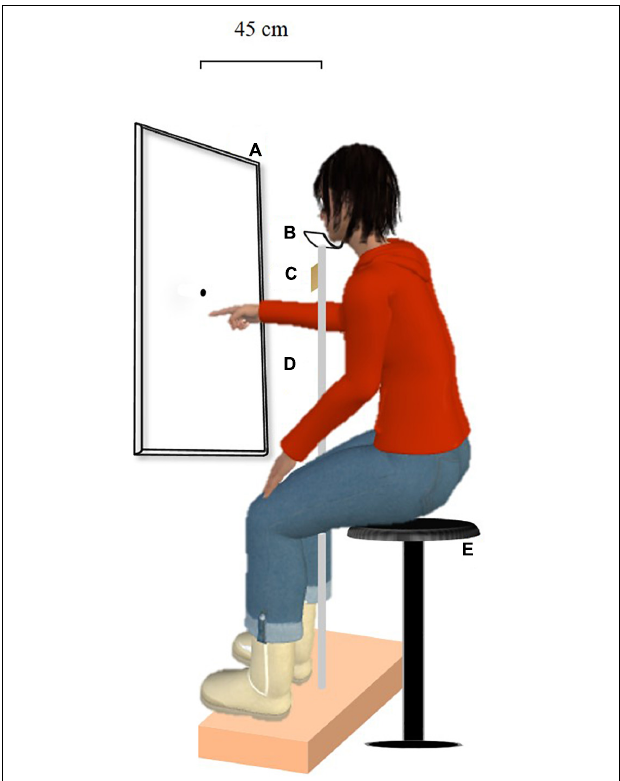
FIGURE 1 | Experimental setup. The participants were seated on a stool adjustable in height facing a touchscreen whose center was aligned with their gaze throughout all test phases. The square bracket depicts the touchscreen-gaze distance of 45 cm. (A) Touchscreen, (B) chinrest, (C) wavy surface, (D) chin rest stem, and (E) stool adjustable in